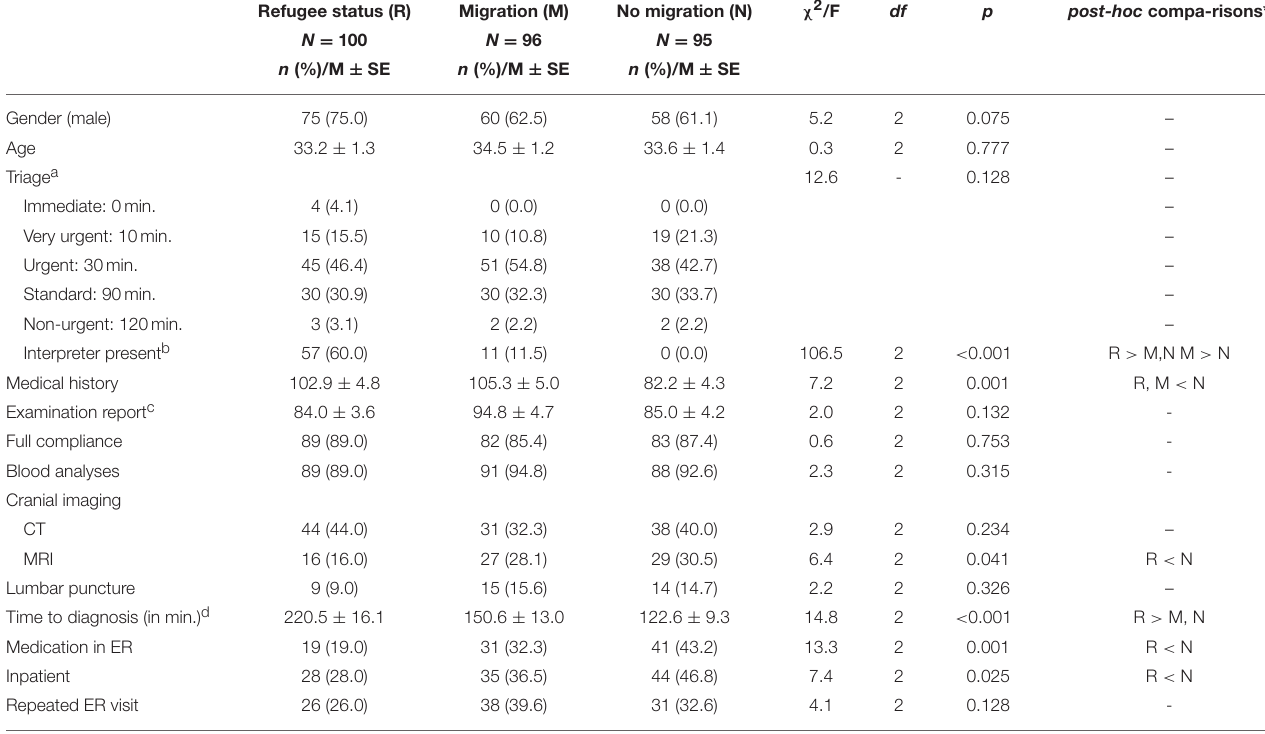
TABLE 1 | Demographical data and medical management of patients.